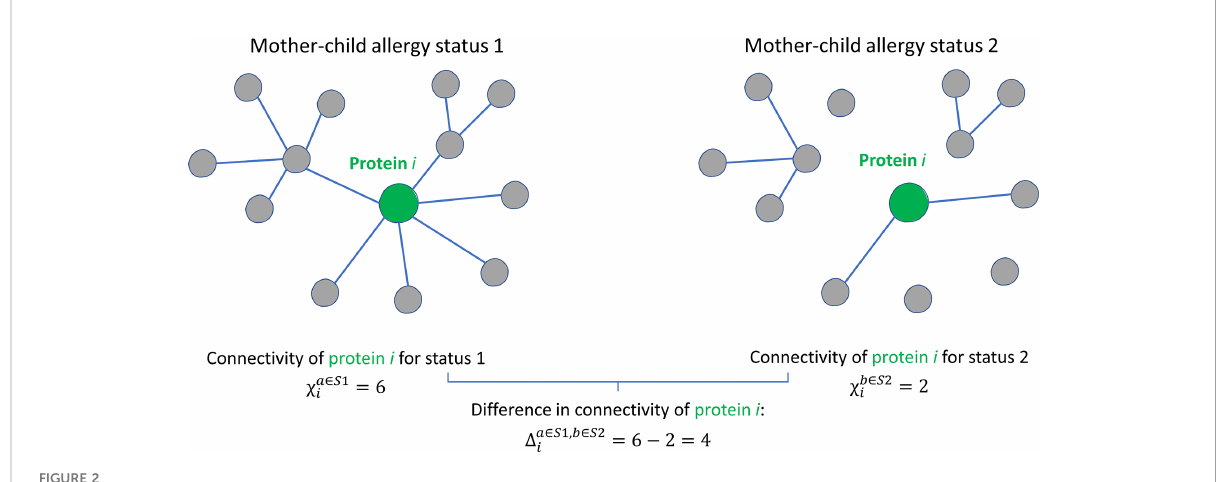
FIGURE 2 Graphical illustration of the concept of protein connectivity and differential connectivity. An unweighted protein-protein association network with 13 proteins is shown for two groups with different mother-child allergy status. Protein i is connected (a connection is represented by the existence of an edge) with a different number of proteins in the two groups. The connectivity c i of protein i is given by the number of connecting edges: 6 for allergy status 1 and 4 for allergy status 2. The differential connectivity for protein i is given by D a ∈ S 1, b ∈ S 2